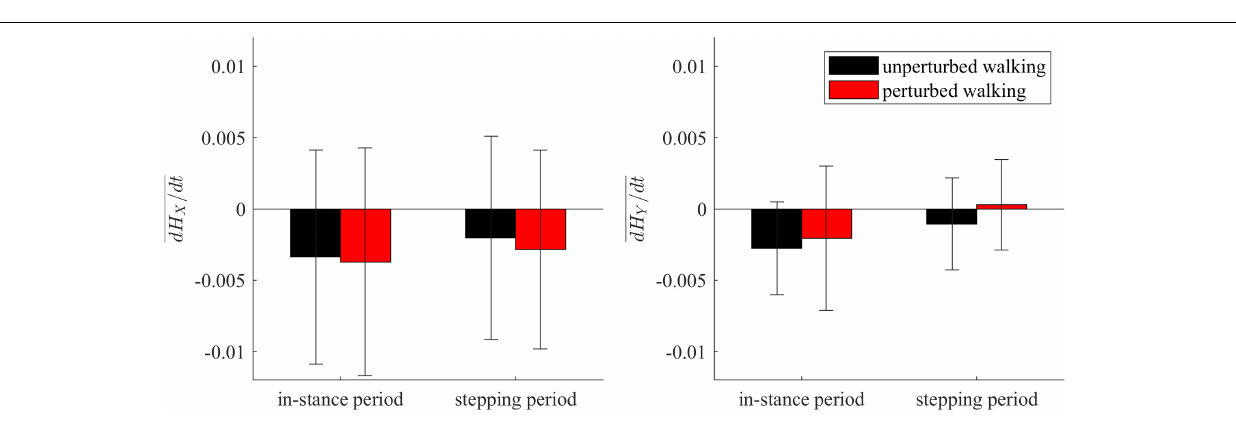
FIGURE 9 | Dimensionless group-average and standard deviations of dH/dt summed over the in-stance and stepping periods. Black corresponds with the unperturbed experimental condition, red with the perturbed experimental